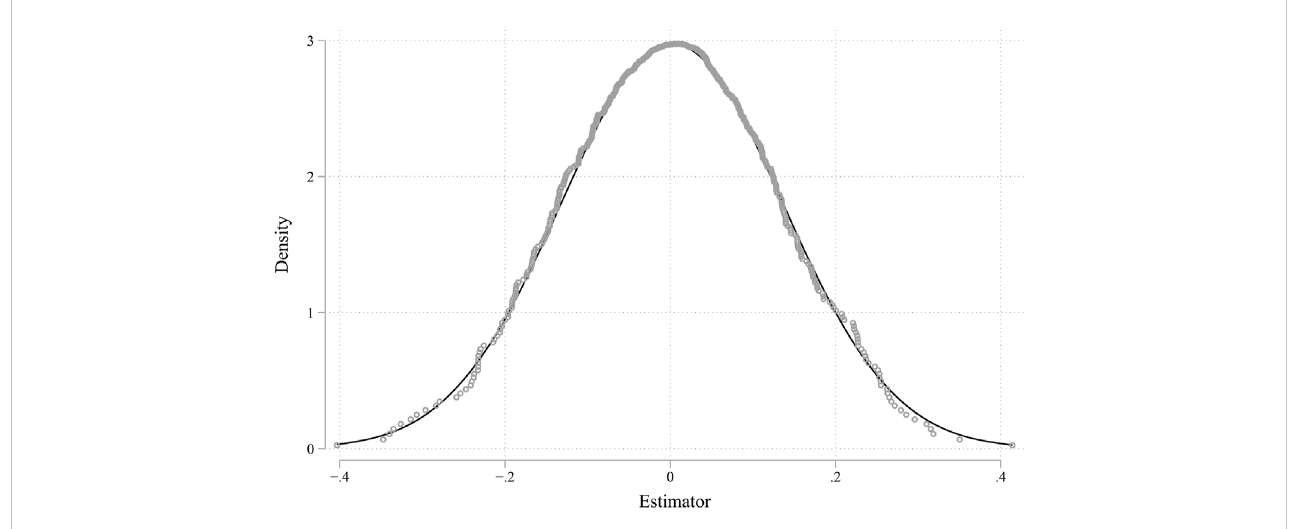
FIGURE 3 Placebo test.